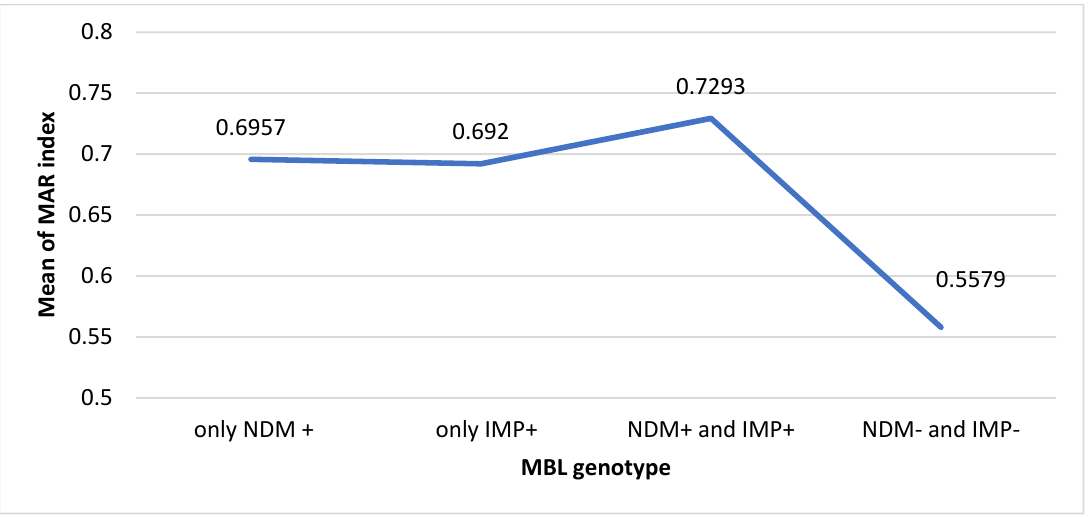
Figure 3. Phenotypic and genotypic agreement of M β L tested genes.